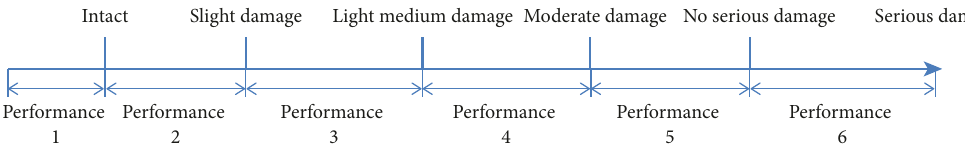
Figure 1: Performance division diagram of members under bending or bending shear